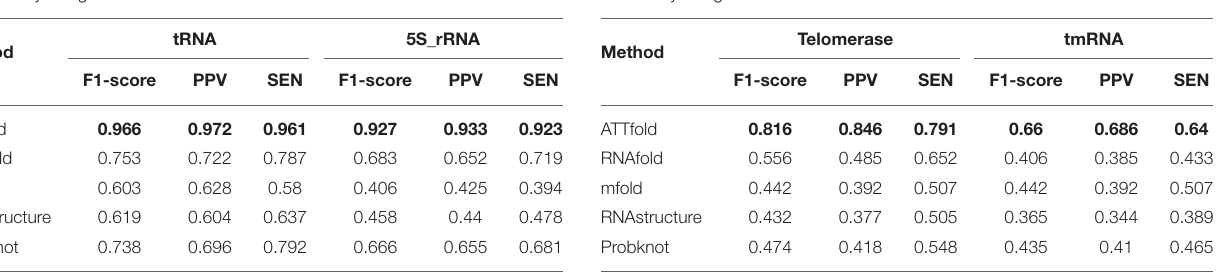
TABLE 6 | Compare ATTfold and four traditional algorithms on Telomerase and tmRNA by using a two-dimensional